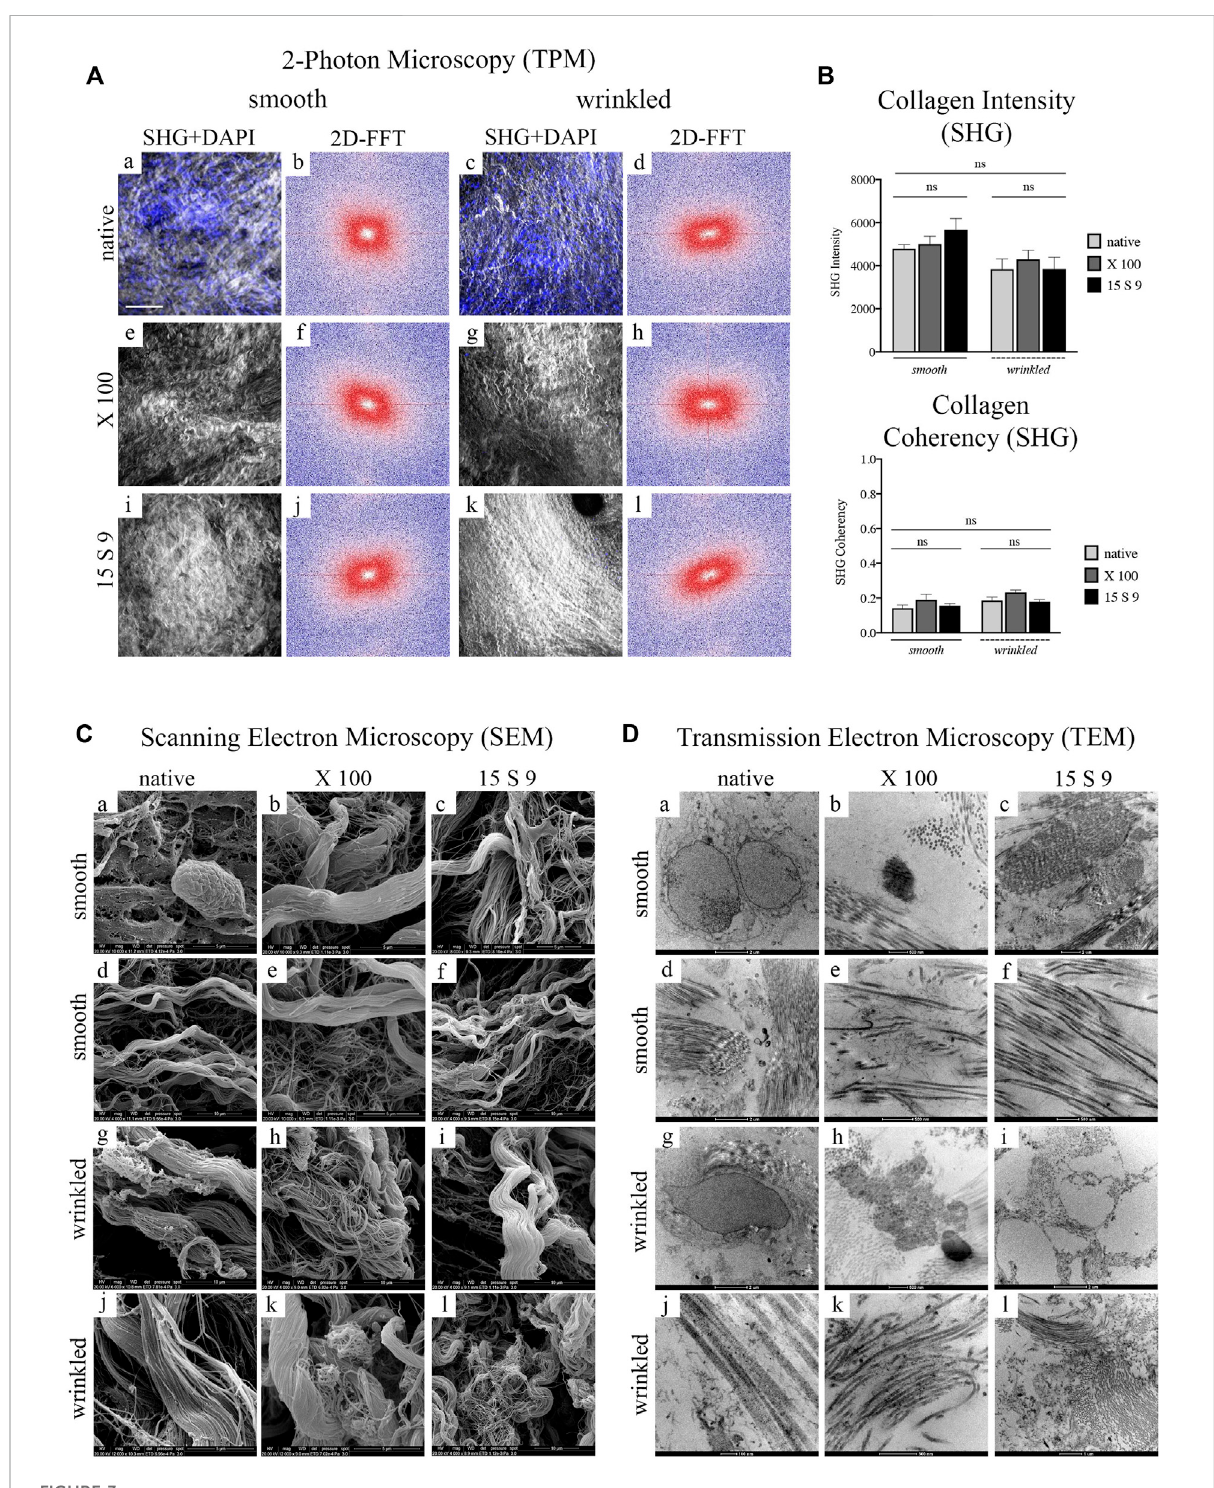
FIGURE 3 Ultrastructure analysis of collagen fi bers after decellularization with X 100 and 15 S 9 in smooth and wrinkled tissue (A) SHG signal and 2D- FFTdiagrams.The SHGsignal ( n =6for each), white andgreystaining intheimages, ofthenative tissue (smooth,a; wrinkled,c)was characterizedby an apparently disorganized fi brillar morphology, con fi rmed by the 2D-FFT images, (smooth, b; wrinkled, d). The 2D-FFT analysis of the smooth and wrinkled native showed a circular shape representation: this is the result of the absence of a single directionality of the native collagen fi ber bundles. The nuclei, stained in blue by the DAPI probe, in the native tissues (smooth, a; wrinkled, c) followedthe apparently disordered course of the